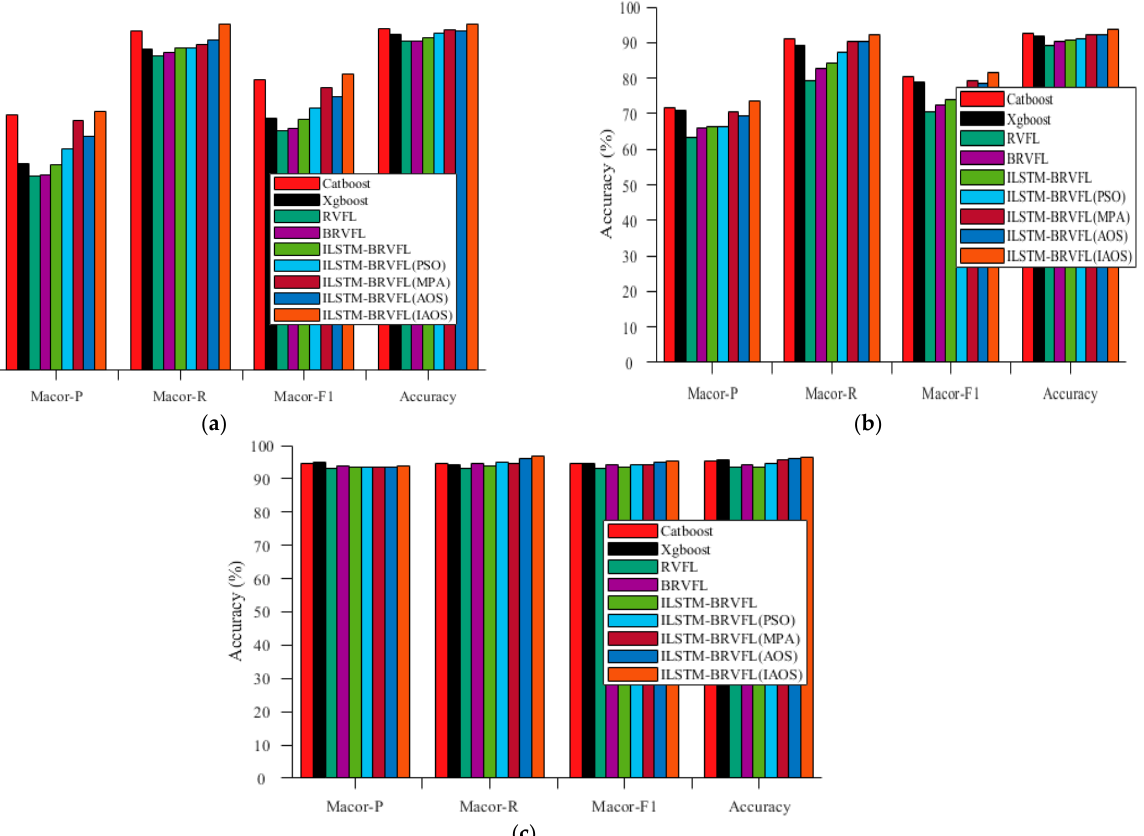
Figure 13. Comparison of evaluation indicators for Catboost + Xgboost + RVFL + BRVFL + LSTM- RVFL + ILSTM-RVFL (PSO) + ILSTM-RVFL (MPA) + ILSTM-RVFL (AOS) + ILSTM-BRVFL (IAOS) on the three sets of logging data: ( a ) evaluation indicators of w 1 ; ( b ) evaluation indicators of w 2 ; ( c ) evaluation indicators of w 3 .